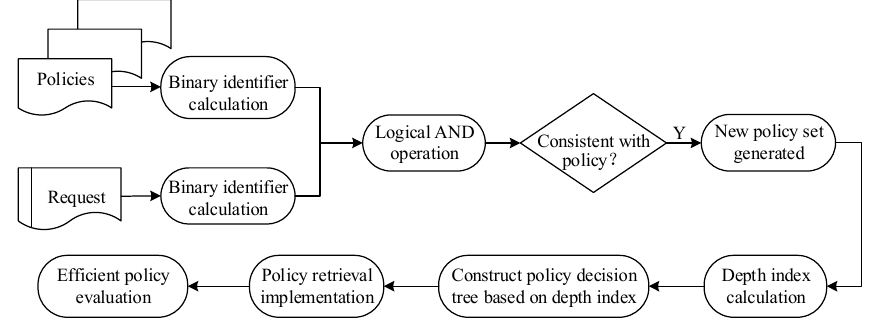
Figure 4. Policy evaluation process based on the attribute and value